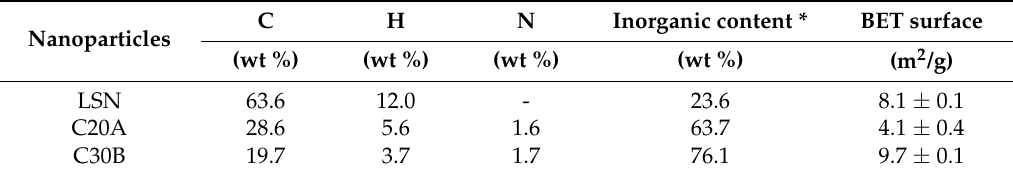
Table 1. Elemental analysis and specific surface of LSN, C20A, and